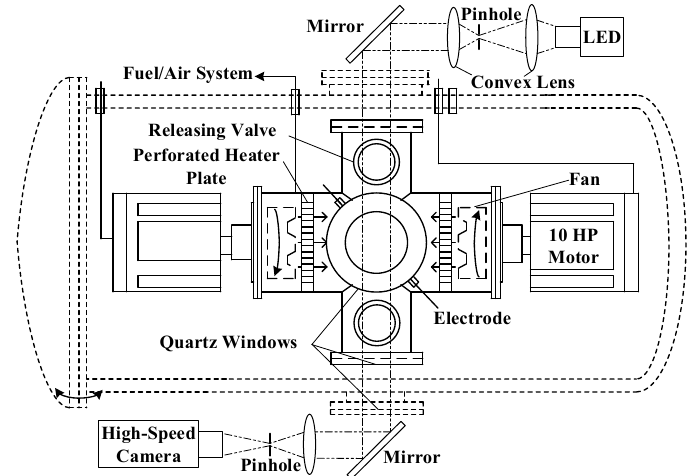
Figure 1. The high-pressure/temperature, double-chamber explosion facility for premixed turbulent combustion studies [27].